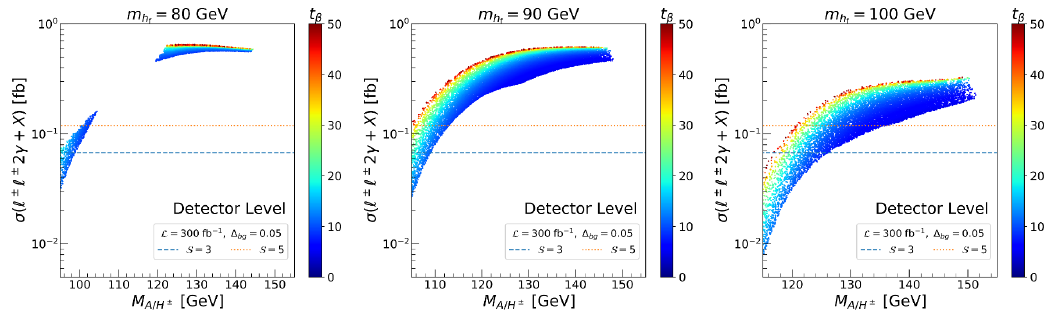
Figure 13 . The detector-level cross section of σ ( pp → 2 γ‘ ± ‘ ± X ) after the basic selection at the 14 TeV LHC about M . The color code denotes t β . The results of m h A/H ± and m h = 100 GeV are in the left, middle, and right panels, f